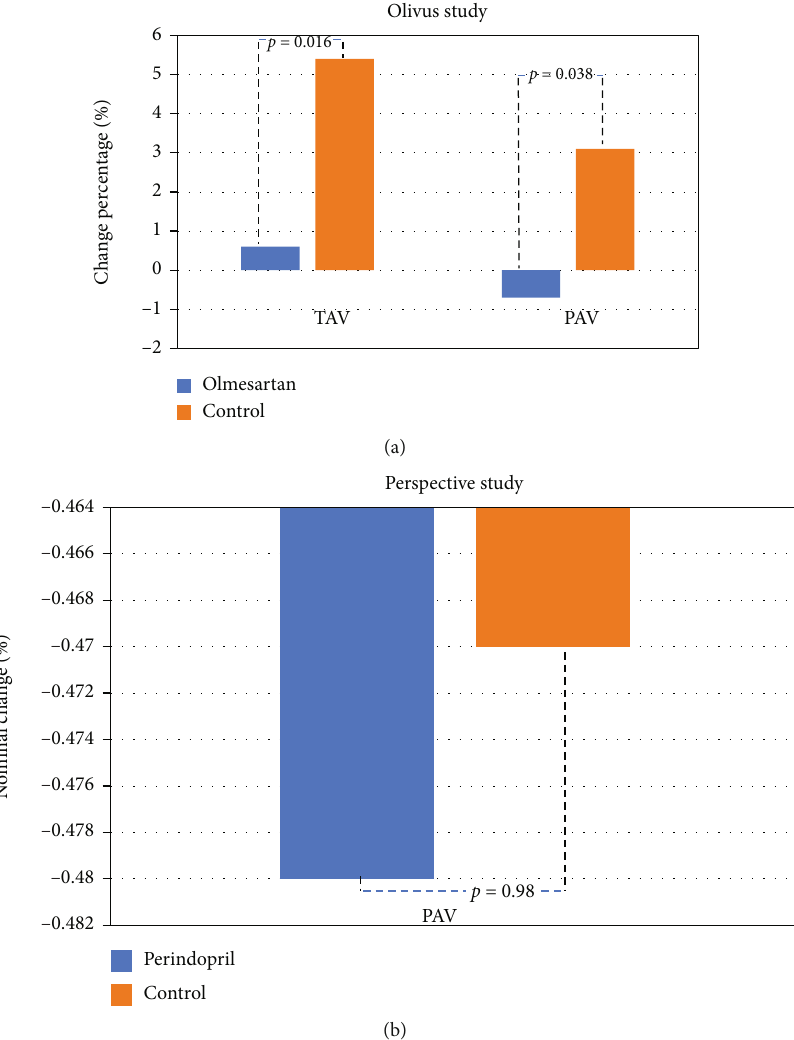
Figure 3: (a) Change percentage of total atheroma volume (TAV) and percentage atheroma volume (PAV) in OLIVUS study in 14-months follow-up. Olmesartan signi fi cantly demonstrates a greater change in both parameters. (b) PERSPECTIVE study demonstrated no signi fi cant di ff erence in PAV change between the perindopril and control